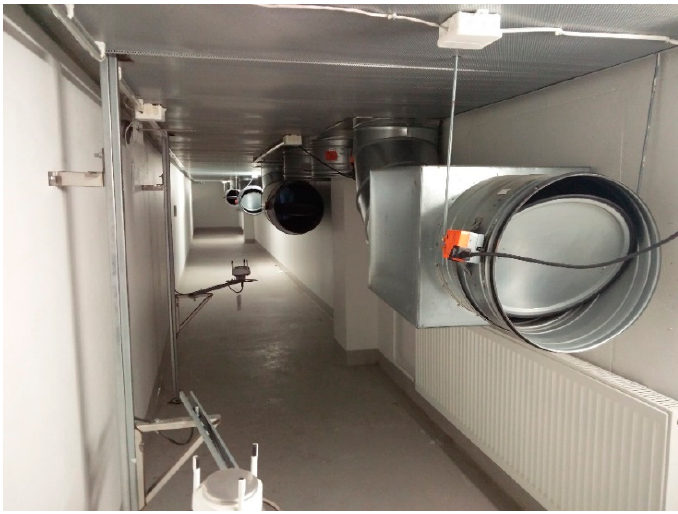
Figure 4. Supply air duct corridor and classroom-specific ducts’ terminal units in the basement. Dampers are opened 20%, as designed.